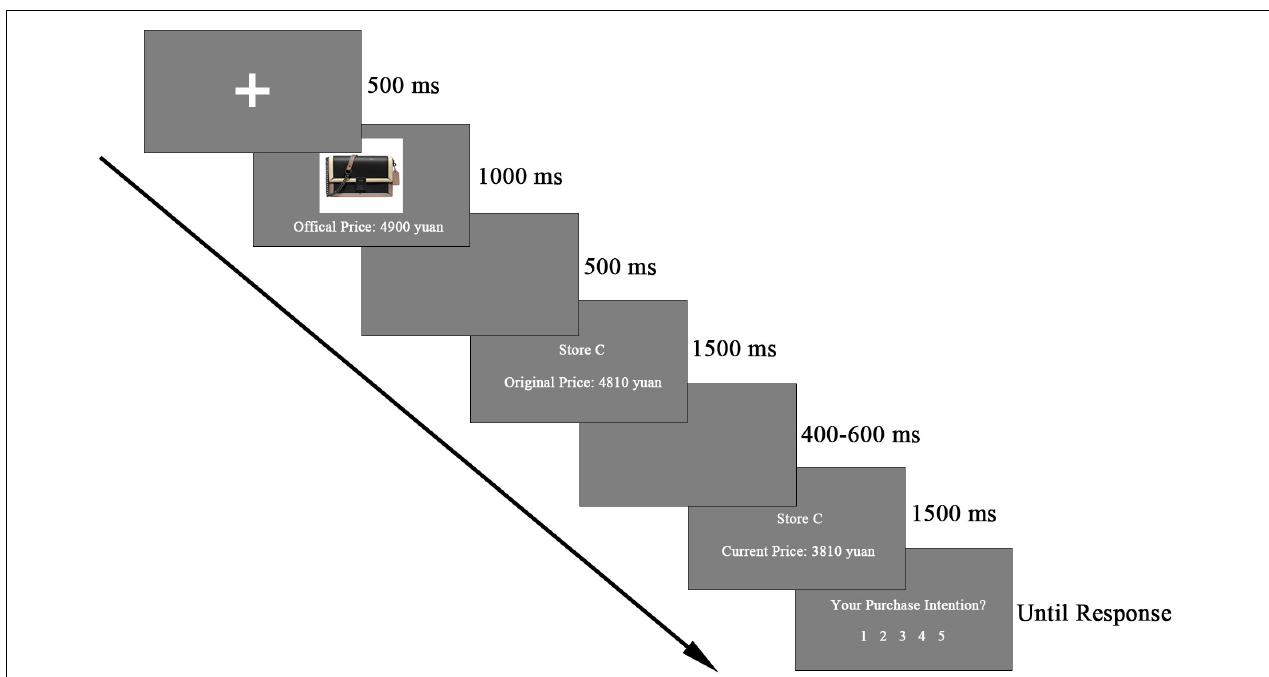
FIGURE 1 | Sequence of stimuli in each trial. First, an affordable luxury product picture was presented. Then an original price (high or low) in a store was presented, and afterward the store’s current price (discounted or non-discounted) was presented. At last, participants need to give their purchase intention according to the original price and current price. Epochs were extracted after current price information